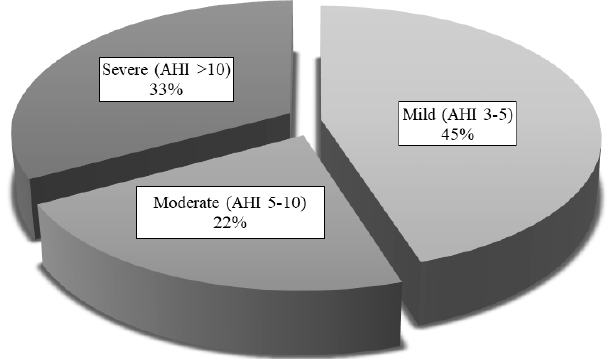
Figure 4. OSAS severity levels for the whole study sample. AHI: apnea-hypopnea index.